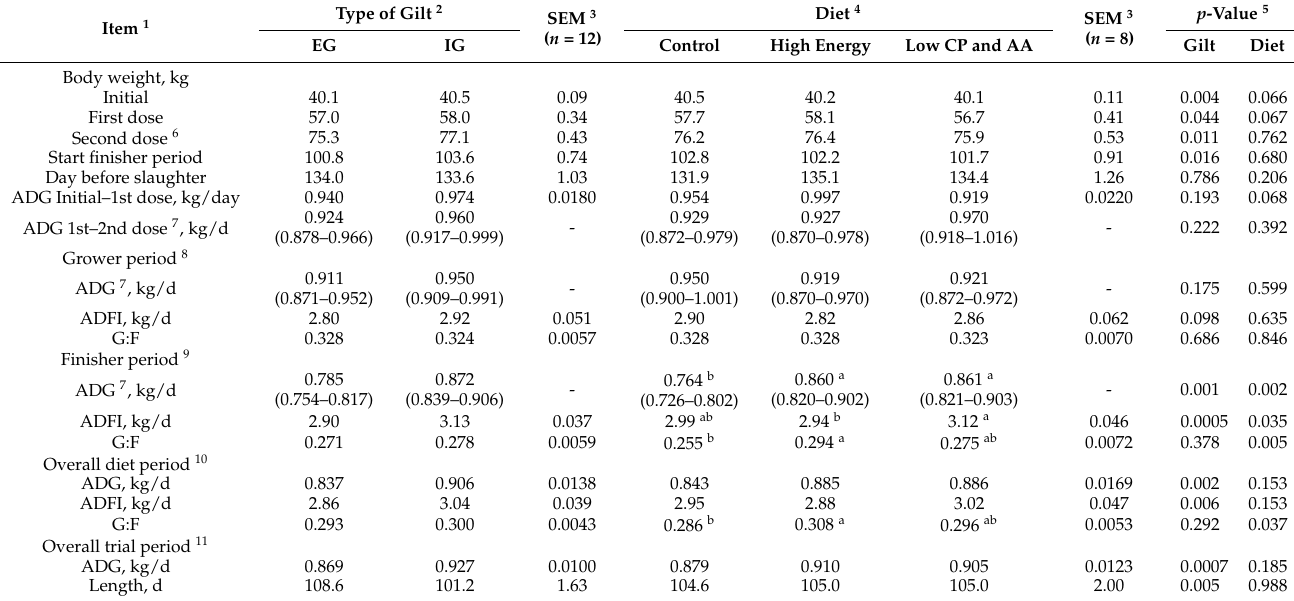
Table 2. Effect of immunocastration and diet on growth performance (least square means) of heavy gilts. Item